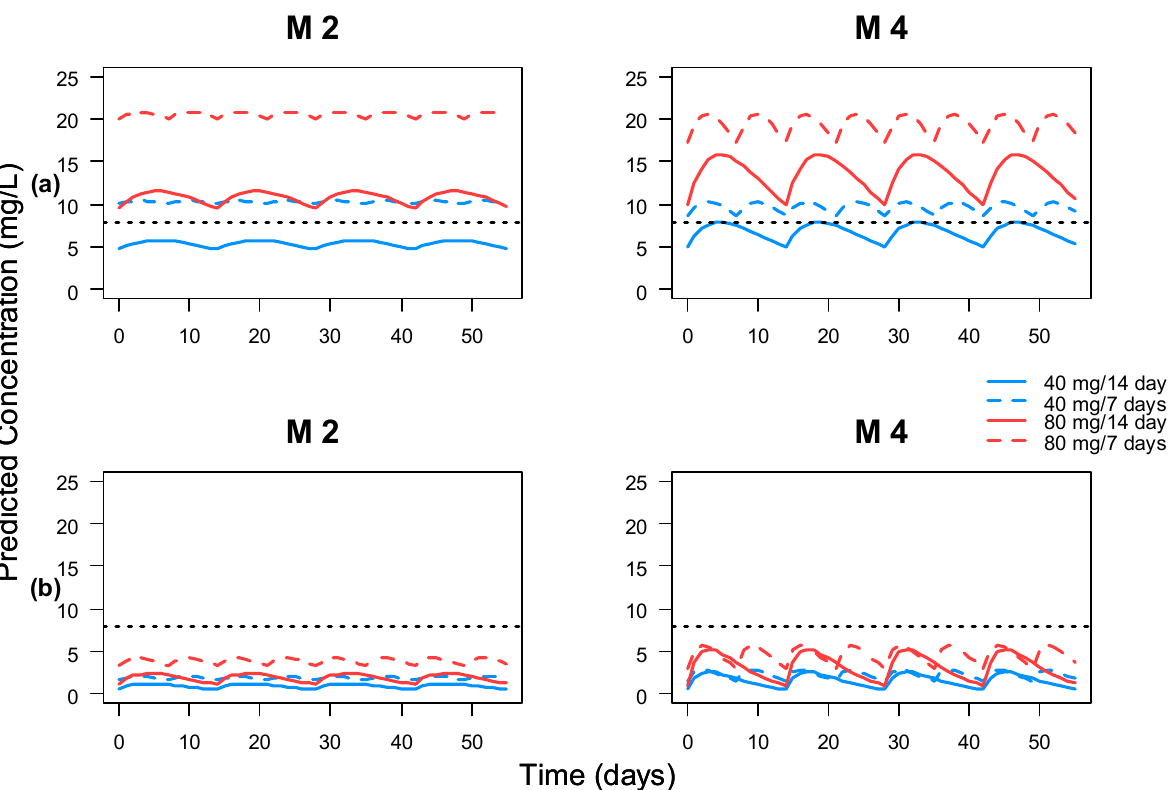
Figure 4. Stochastic simulation of the 25th percentile of serum concentrations over time for M2 and M4. Black dotted line was drawn to highlight the line corresponding to 8 mg/L. ( a ) Serum concentrations of patients without AAA. ( b ) Serum concentrations of patients with AAA. The M numbers represent the models described in Table 1.